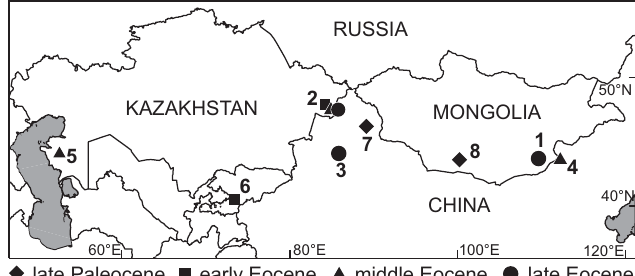
Material. —MPC-MX 1/108, an isolated tooth. This specimen was collected by one of the co-authors, TC, during the paleonto- logical expedition on 4 th September, 2008 (Tsubamoto et al. 2010) from Ergilin Dzo (= Ardyn Obo) located in the southern part of Dornogobi Aimag (eastern Gobi Desert), southeastern Mongolia (43°19’40’’N, 109°07’42’’E, map datum: WGS84; Yanovskaya et al. 1977; Dashzeveg 1993; Tsubamoto and Tsogt baatar 2008; Fig. 1: 1) in Ergilin Dzo Formation (= Ardyn Obo Formation by Berkey and Granger 1923; Ergilin Dzo svita/suite by Yanovskaya et al. 1977 and Dashzeveg 1993); late Eocene (Ducrocq 1993; Meng and McKenna 1998; Tsubamoto et al. 2004, 2008).